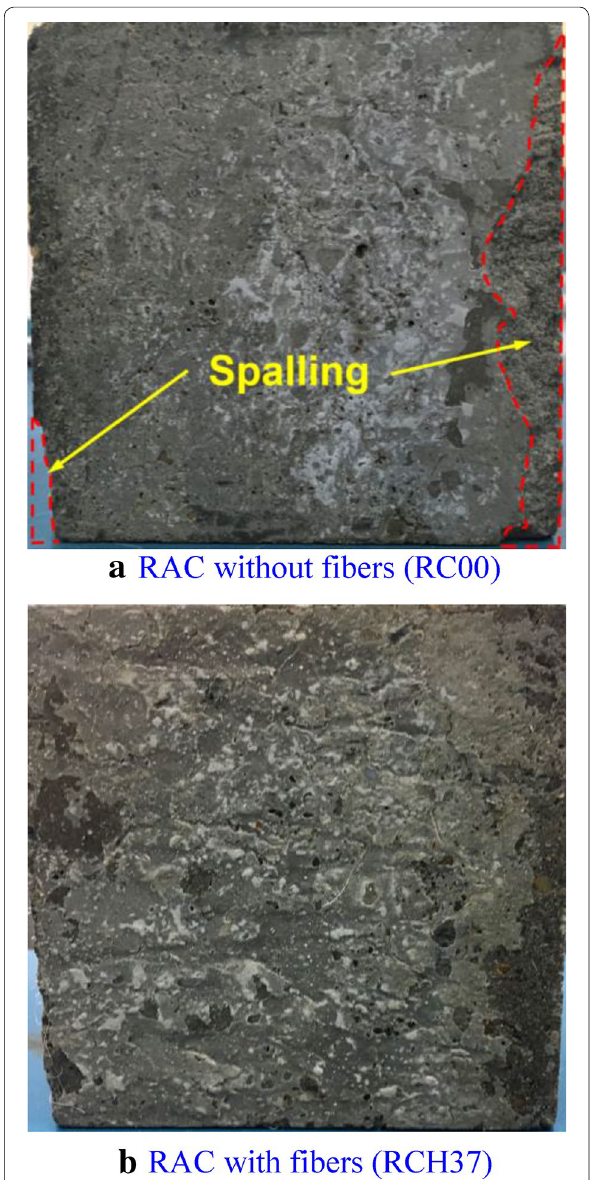
Fig. 6 Apparent damage of RAC specimens after 50 salt-solution freeze–thaw cycles: a RAC without fibers and b RAC with fibers.